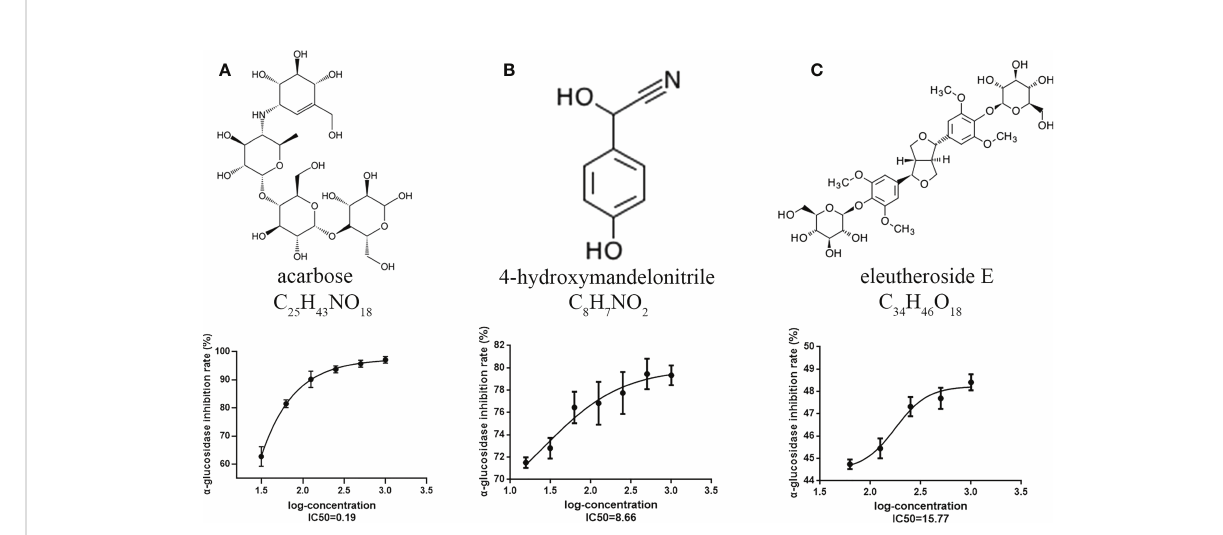
FIGURE 3 Alpha-glucosidase inhibitory activity assay of DAMs. (A) Acarbose. (B) 4-hydroxymandelonitrile. (C) Eleutheroside E. Each value represents the mean ± SD, and error bars represent signi fi cant differences (n = 3, P < 0.05